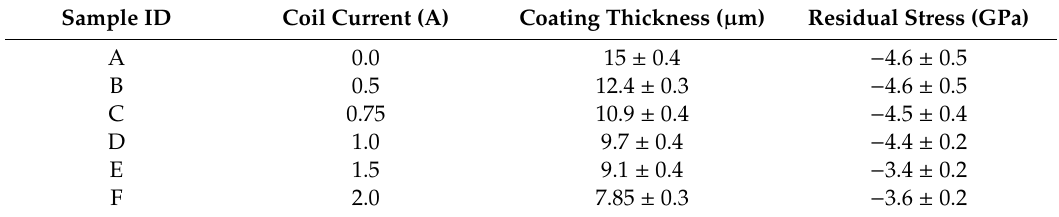
Table 1. Investigated coatings and their respective coil current, coating thickness, and residual stress. Sample